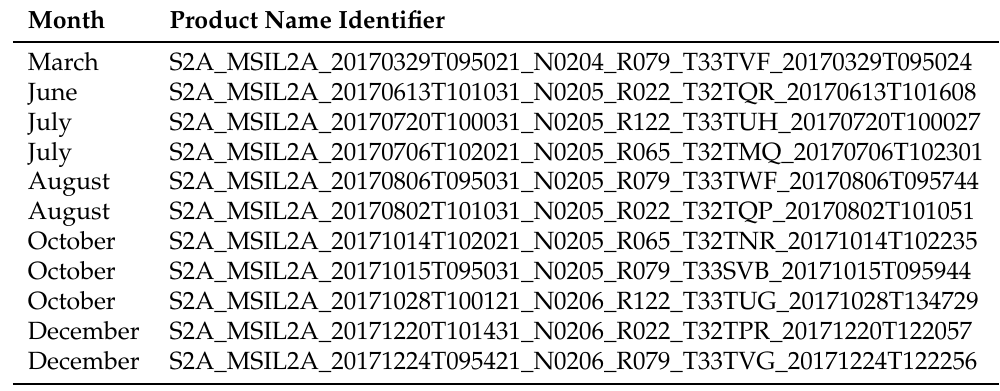
Table 1. List of Sentinel-2 products used for the generation of the dataset.